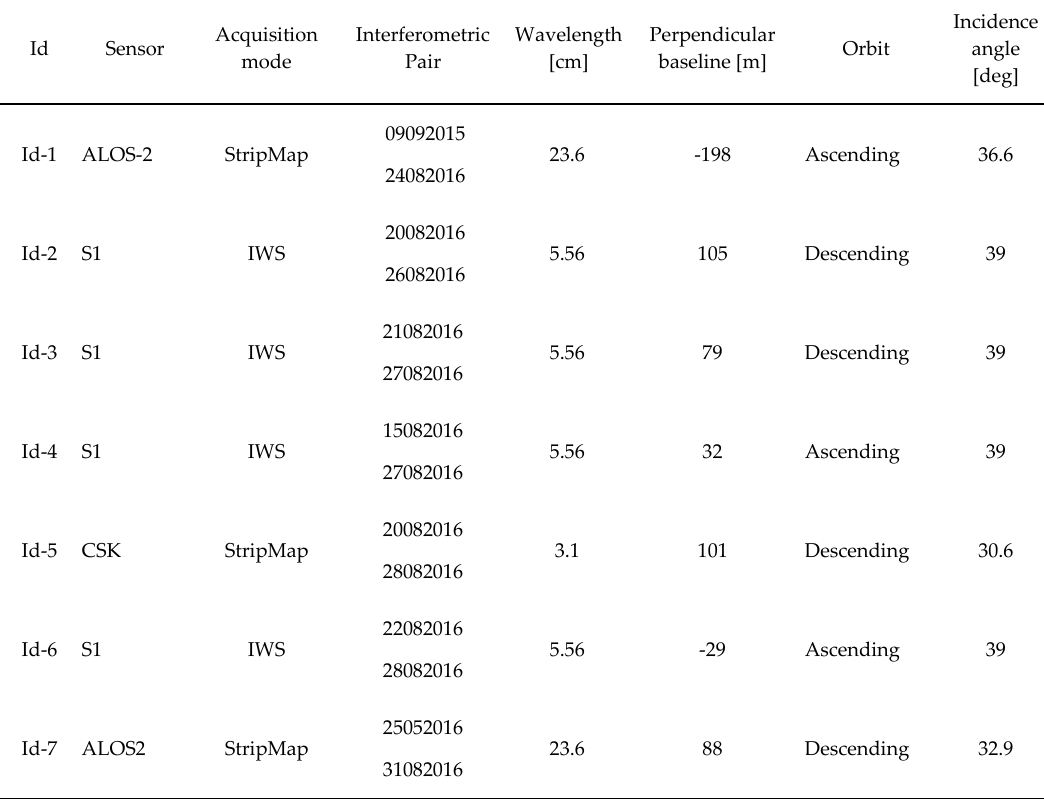
Table 1: Co-seismic interferometric pairs available and processed. S1 is Sentinel-1, CSK is Cosmo-SkyMed. IWS means Interferometric Wide